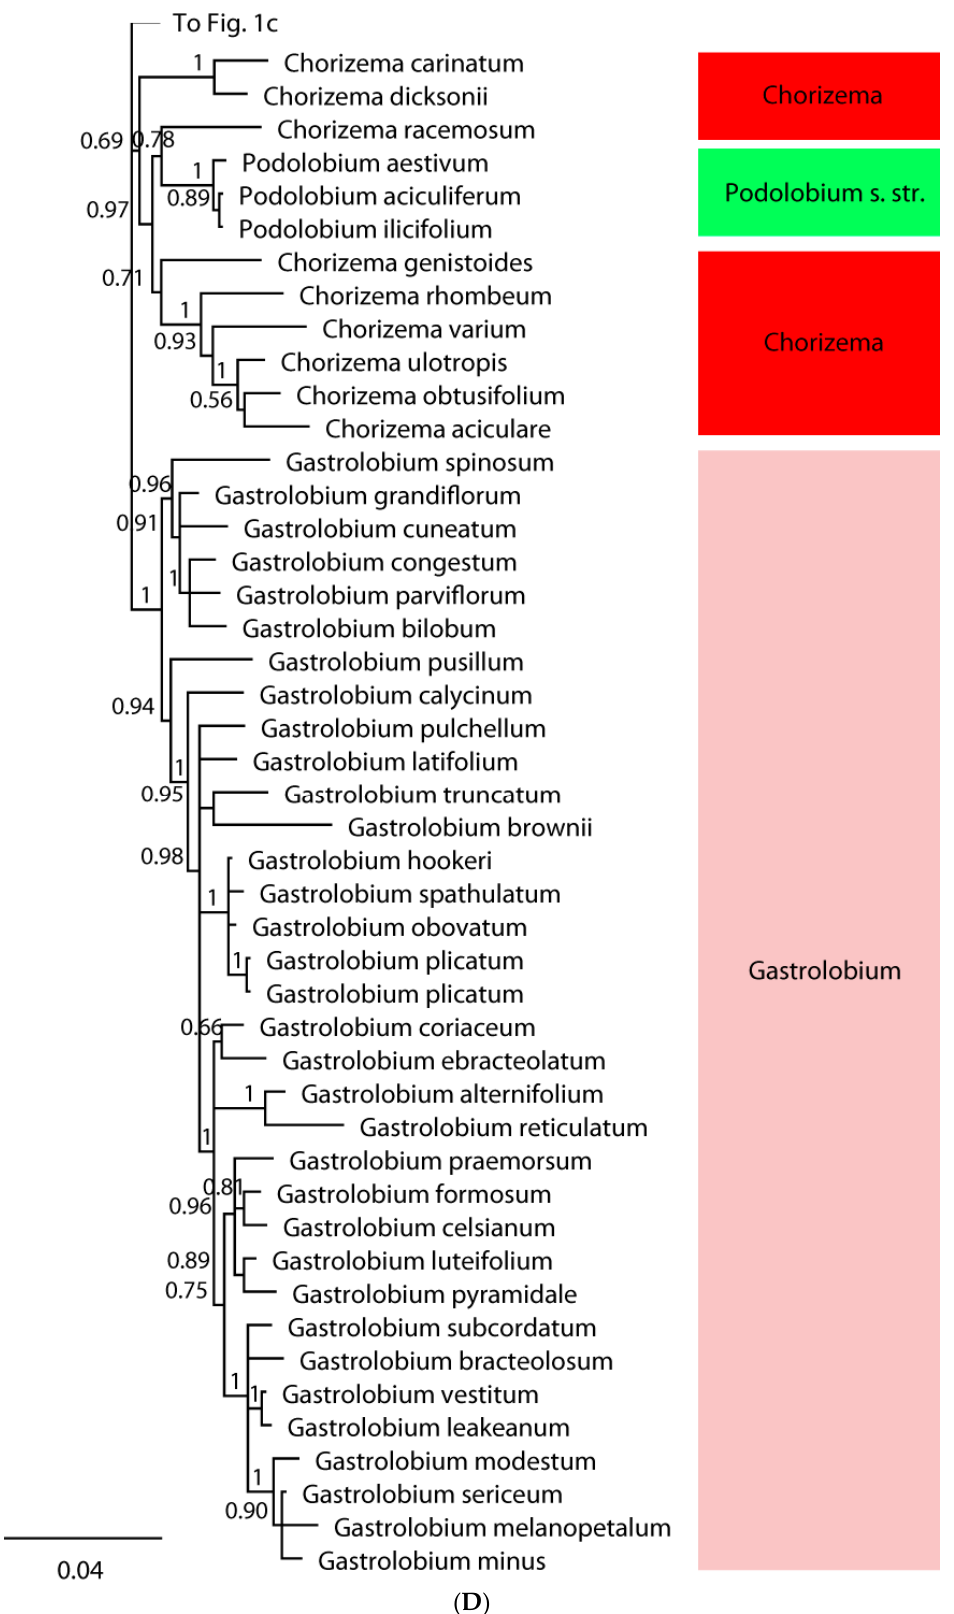
Figure 1. ( A – D ) Phylogeny of Fabaceae tribe Mirbelieae inferred from trn L intron and trn L–F spacer (cpDNA). Posterior output from MrBayes. Numbers above lines are posterior probability.